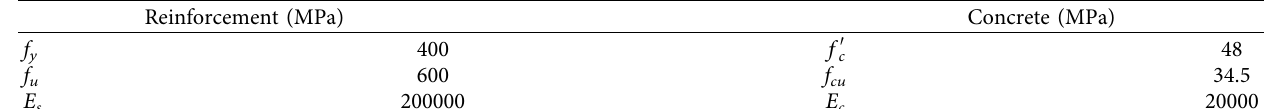
Figure 3: Cofn–Manson constant (a) and half-cycle terms defned (b) [31]. Table 2: Materials